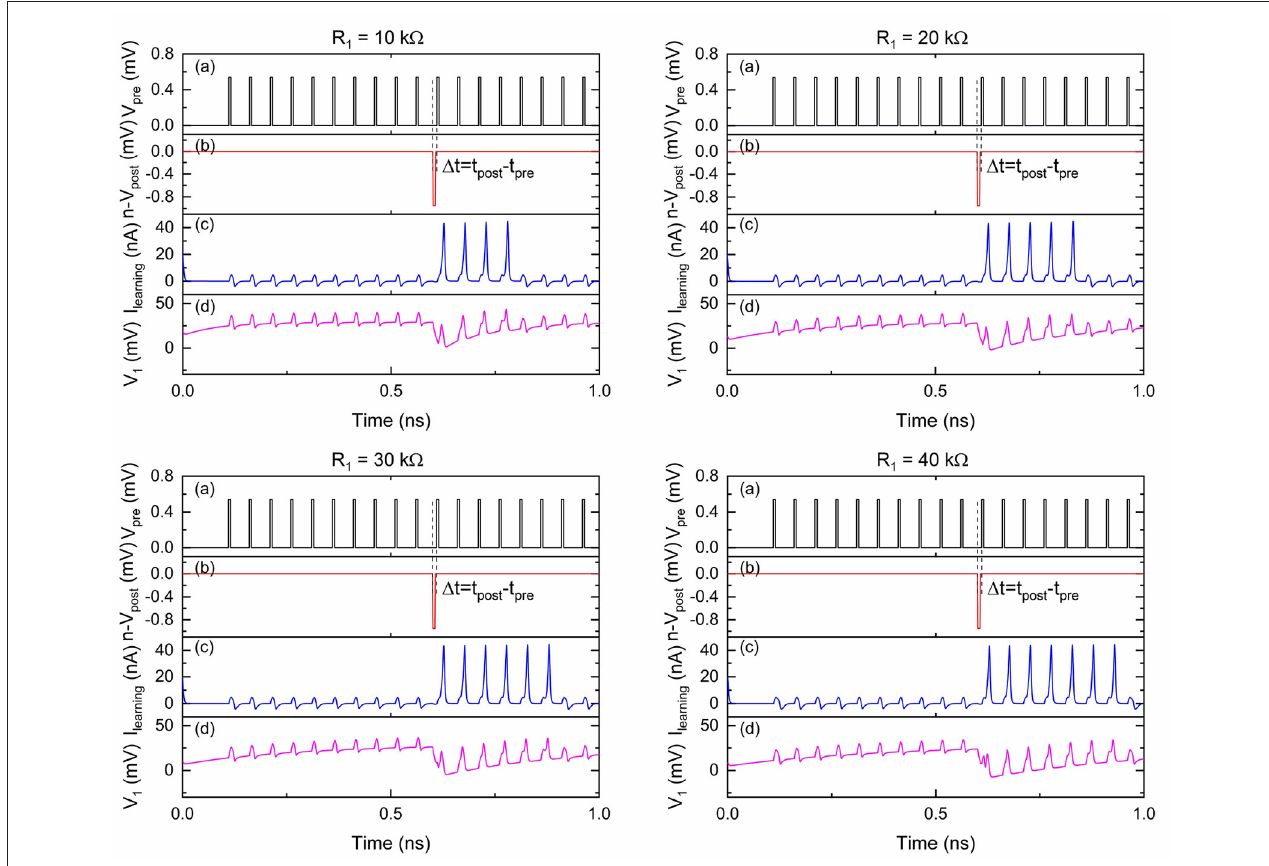
FIGURE 5 | Simulation results of the circuit shown in Figure 4 with different R 1 values. V pre was 0.54 mV and V post was 0.95 mV. The critical voltage values used for Q 0 – Q 2 were 0.75, 0.56, and 0.31 mV, respectively. C 1 was 9.2 fF and C 2 was 1.2 fF. V b1 was 0.03 mV and V b2 was 0.5 mV. R 1 was 10/20/30/40 k (cid:127) . (a) Input signal